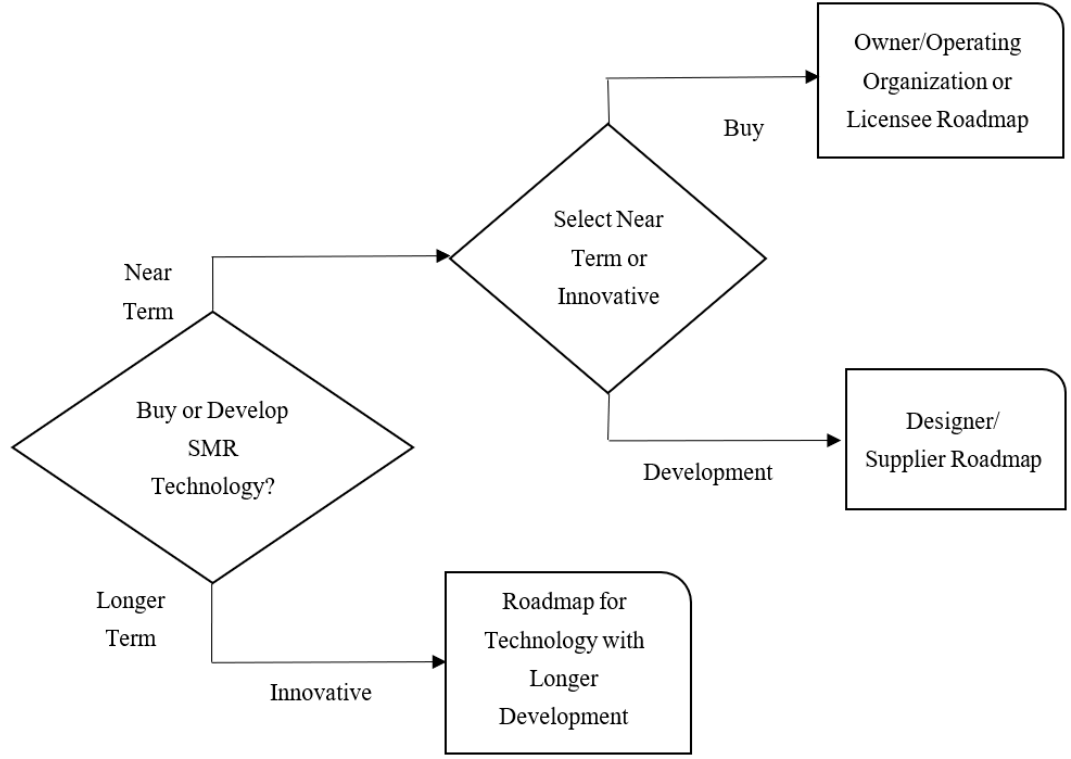
Figure 2. Flowchart of SMR technology roadmap—Own elaboration based on data from [52].